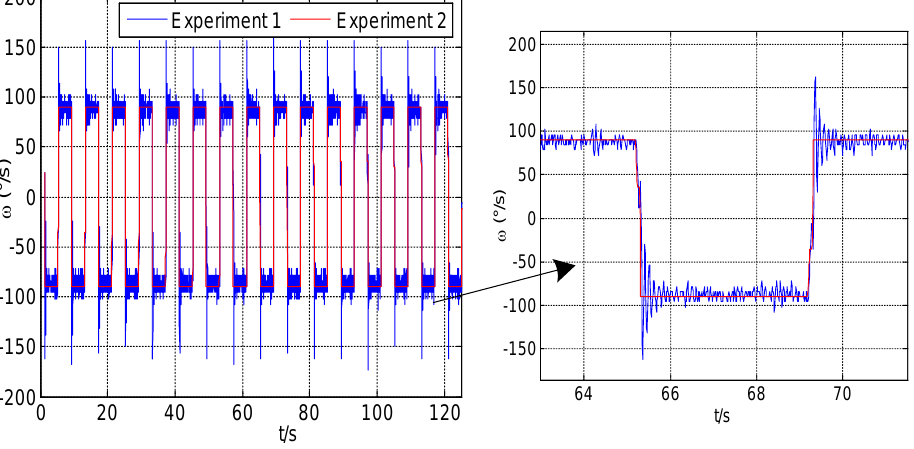
Figure 12. Modulation angular rate of Experiment 1 and Experiment 2.